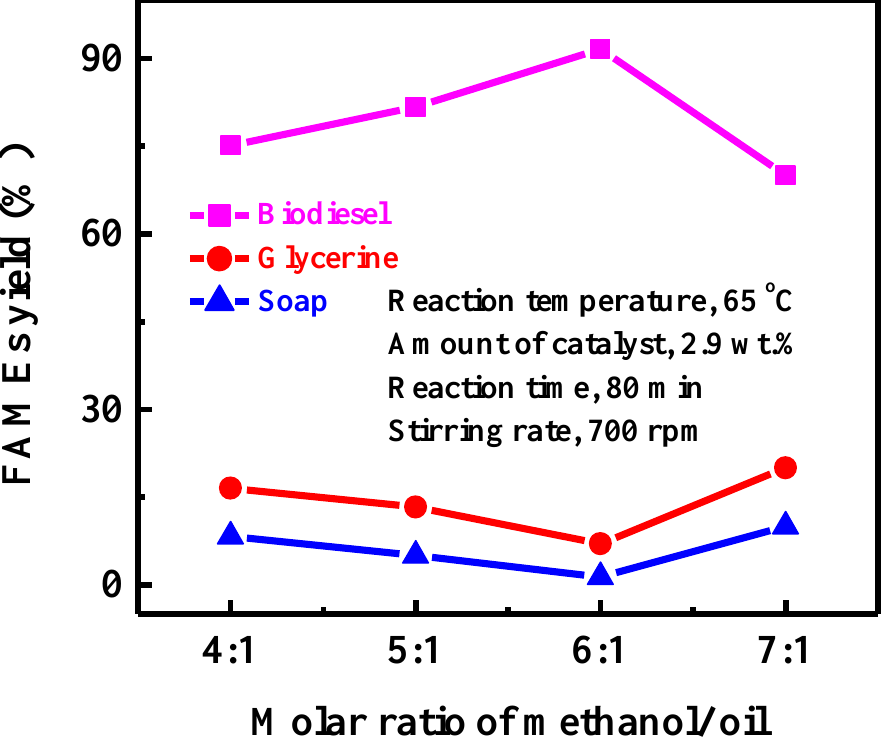
Figure 3. The e ff ect of methanol to oil molar ratio on RTOB Figure 3. The effect of methanol to oil molar ratio on RTOB yield.